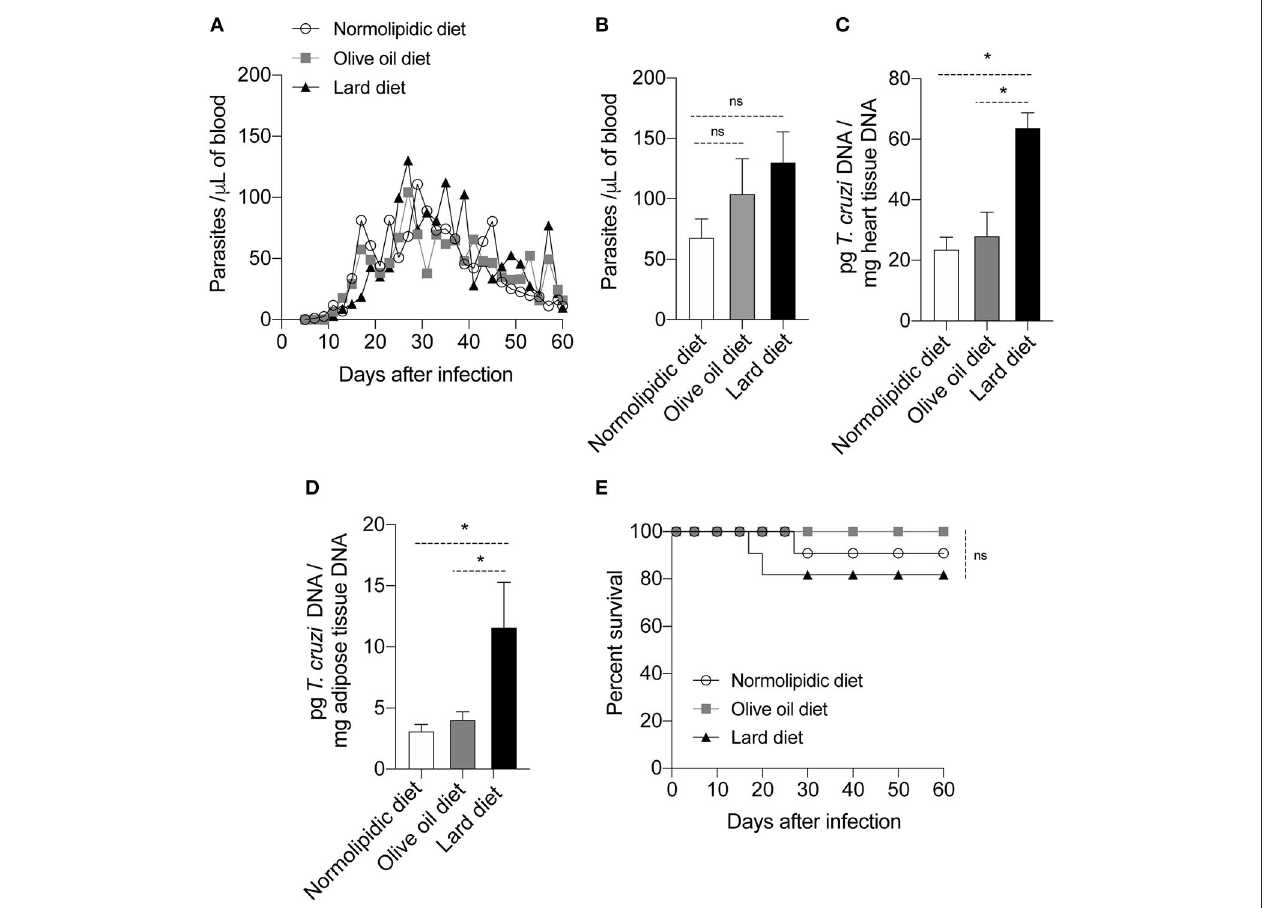
FIGURE 2 | Parasitism and survival rate of mice fed with different types of hyperlipidic diets. Newly weaned C57BL/6 mice were fed with either a normolipidic diet ( n = 8), monounsaturated fatty acid diet with olive oil ( n = 8) or saturated fatty acid diet with lard ( n = 8). At the day 60 of diet, mice were intraperitoneally infected with 50 blood trypomastigote forms of T. cruzi Colombian strain and (A) the blood parasite levels were monitored daily. (B) Number of parasites circulating in the mice blood at the day 27 after infection. At the day 30 post infection the DNA was extracted from (C) the heart and (D) adipose tissue and the amount of DNA from parasites were quantified in the tissues by real time PCR assay. (E) The survival rate of mice fed with normolipidic diet, olive oil diet or lard diet was monitored daily for 35 days. ns, not statistically different; * p < 0.05 by one-way ANOVA followed by Tukey post-hoc